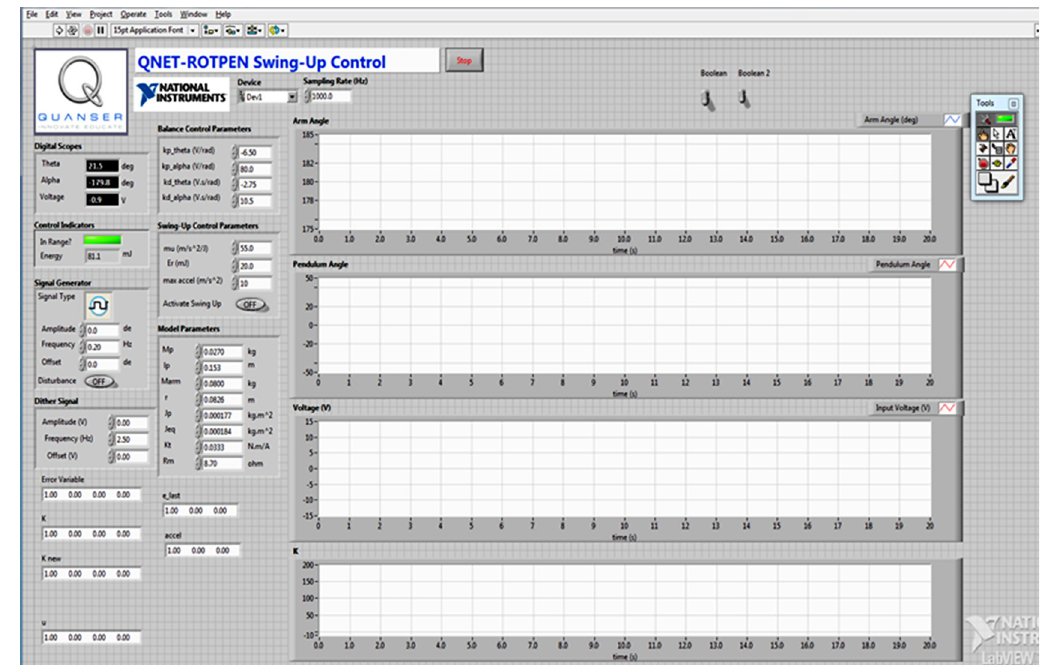
Fig 6. GUI of the LabVIEW control